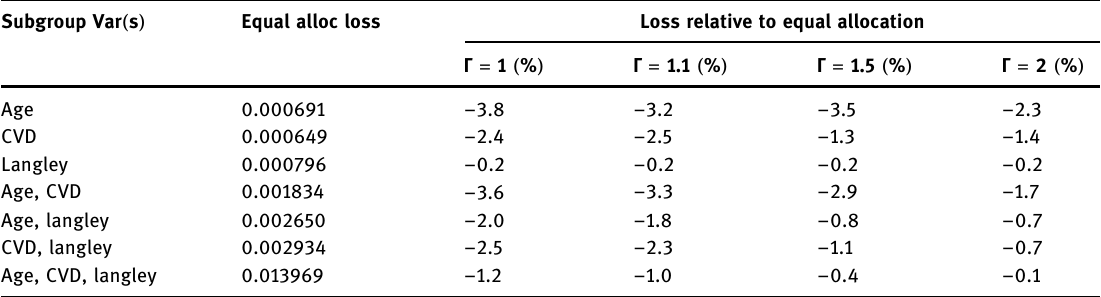
Table A10: L 2 loss comparisons for regret - minimizing allocations versus equal allocation, rectangular con fi dence regions Subgroup Var ( s